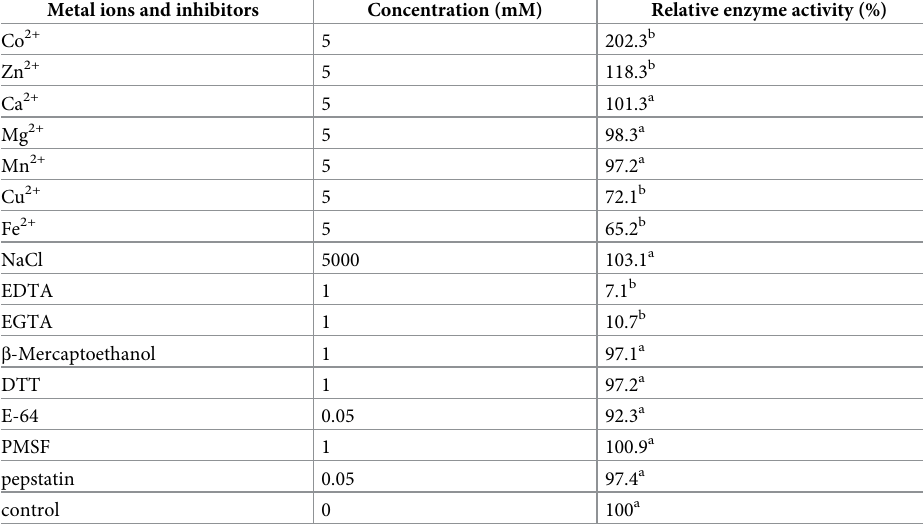
The enzyme activity of HypZn in phosphate-citrate buffer pH 7.0 at 35˚C (optimal conditions) was designated as standard enzyme activity 100%. Values are reported as the mean of triplicate measurements. Different lowercase